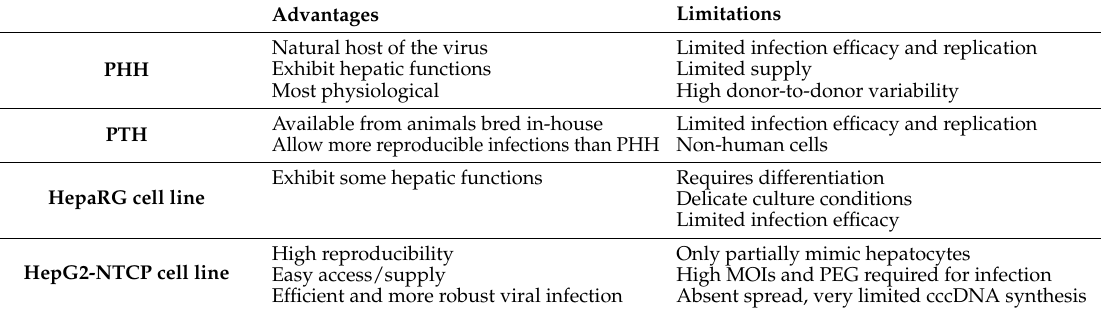
Table 1. Cell culture models susceptible for HBV and HDV infection. The respective model systems and their key advantages and limitations are shown. Advantages Limitations Natural host of the virus Limited infection efficacy and replication PHH Exhibit hepatic functions Limited supply Most physiological High donor-to-donor variability Available from animals bred in-house Limited infection efficacy and replication PTH Allow more reproducible infections than PHH Non-human cells Exhibit some hepatic functions Requires differentiation HepaRG cell line Delicate culture conditions Limited infection efficacy High reproducibility Only partially mimic hepatocytes HepG2-NTCP cell line Easy access/supply High MOIs and PEG required for infection Efficient and more robust viral infection Absent spread, very limited cccDNA